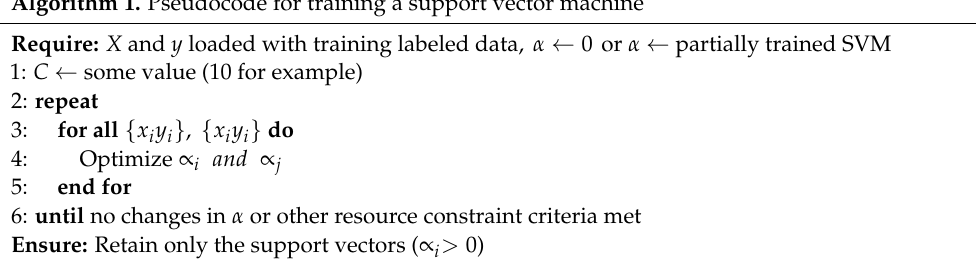
Algorithm 1. Pseudocode for training a support vector